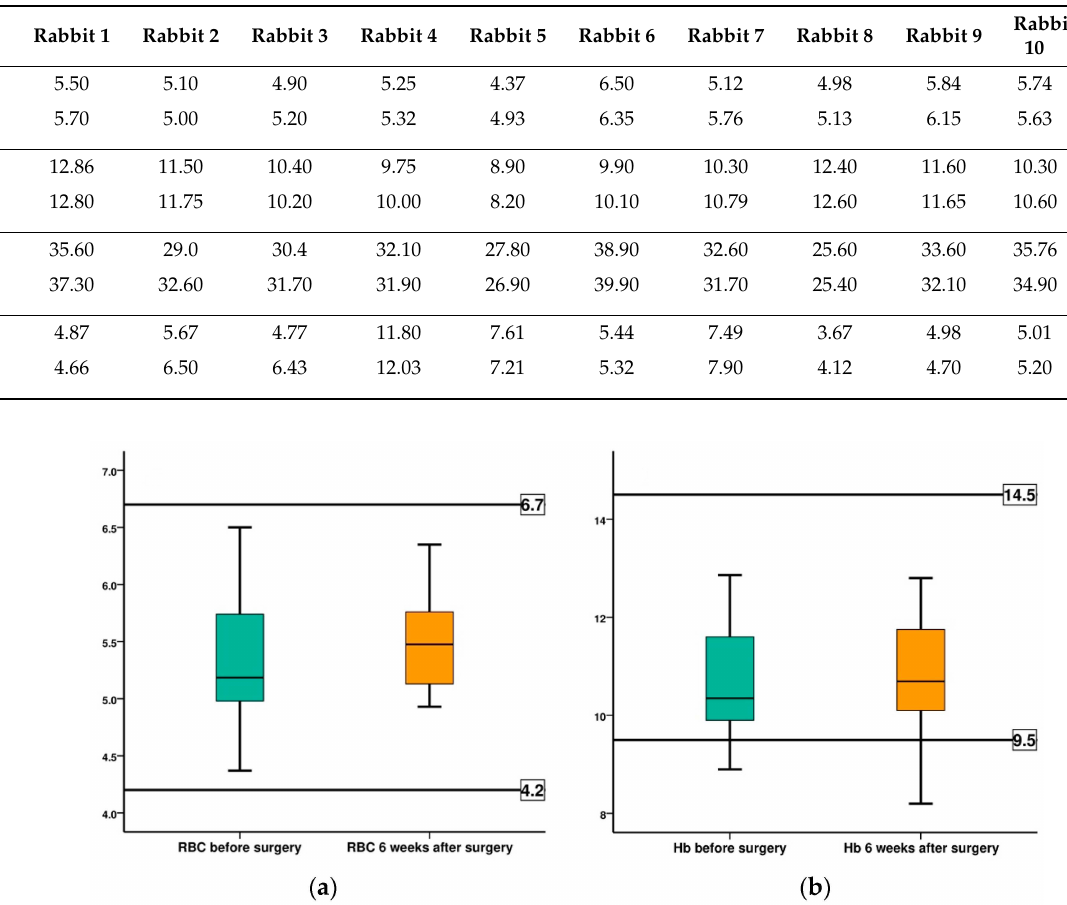
Table 10. Hemogram and leucocyte evolution comparison.